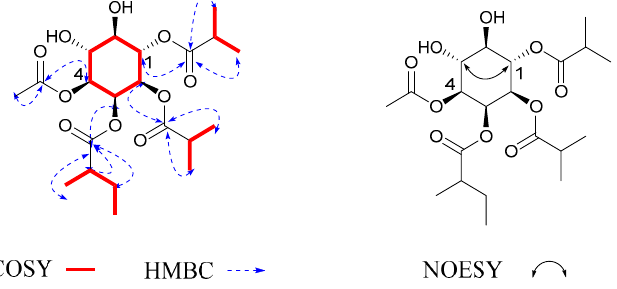
Figure 3. 1 H- 1 H COSY, key HMBC and NOE correlations of compound 2 . Compound 3 was obtained as a colorless solid. Its molecular formula, C 25 H 40 O 11 , was determined by positive HR-ESI-MS at m / z 534.2916 [M + NH 4 ] + (calcd. 534.2914) with six degrees of unsaturation. The NMR data of 3 were similar to those of 1 (Tables 1 and 2), which meant that they had the same cyclohexane structure. The main difference was the substituent patterns of the inositol ring. Through 1 H- 1 H COSY and HMBC (Figure 4) spectra, the correlation from H-1 to C-Ac indicated that the Ac was attached to C-1; the correlation from H-2 to C-2MB indicated that the 2MB was attached to C-2; the correlation from H-3 to C-2MB (cid:48) indicated that the 2MB (cid:48) was attached to C-3; the correlation from